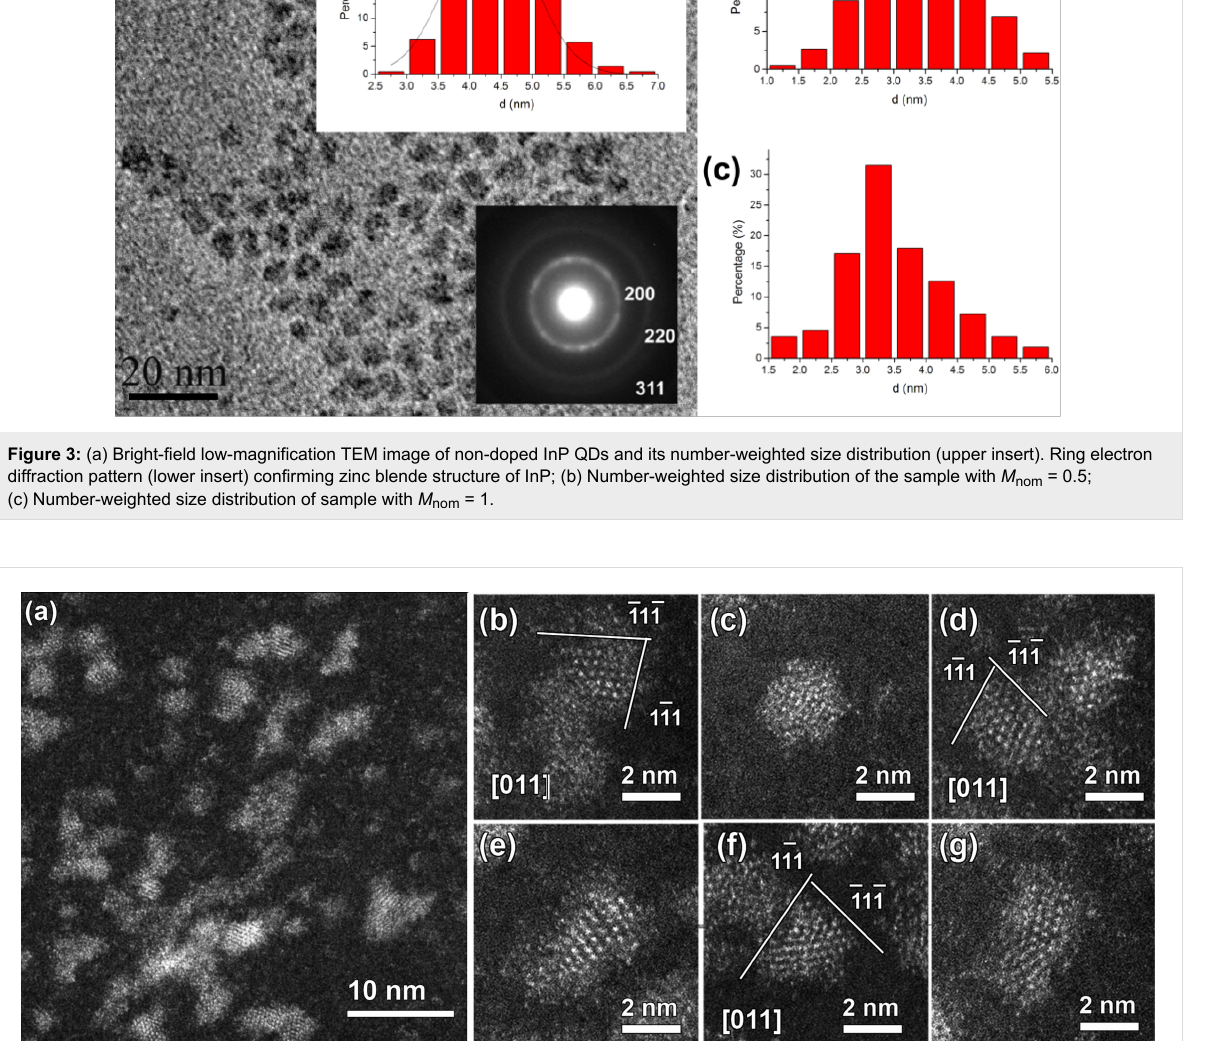
Figure 4: (a) Low-magnification HAADF-STEM images of Zn/InP QDs and (b–g) selected high-resolution images of single QDs along different zone axes. Notice faceting of the core and the presence of a disordered shell.